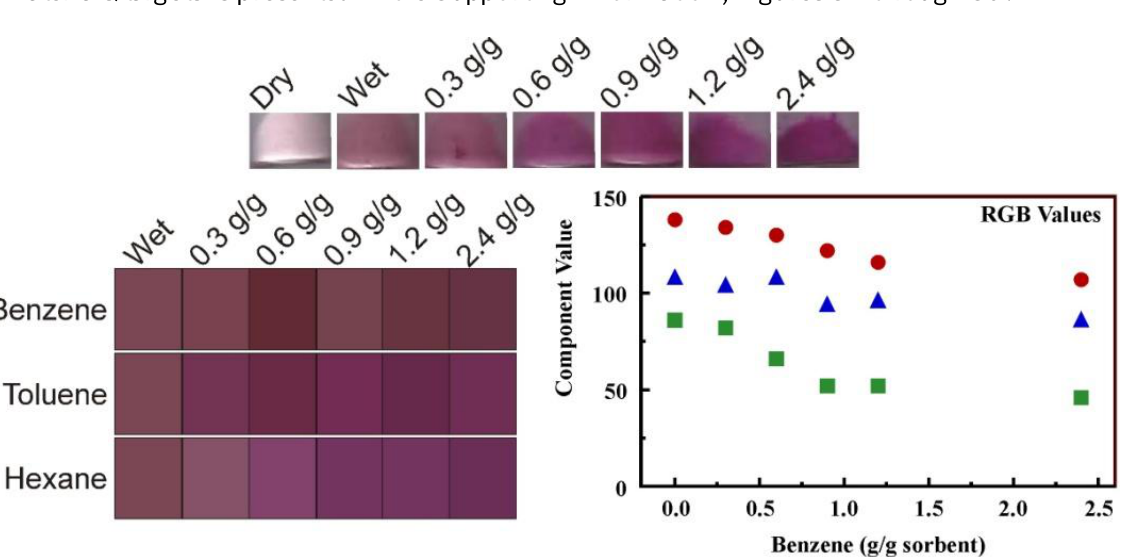
Figure 7. Interaction of FeC TPP-embedded B100 with targets. Shown here are scanner 1 images of the material following exposure to varying concentrations of benzene. Also shown are simulated images generated based on average RGB values for FeC TPP-embedded 1 B100 following exposure to varying target concentrations and the dependence of RGB image color values on target concentration for the interaction of benzene with FeC1TPP-embedded B100 (red circles = R, blue triangles = B, green squares = G). Complete data for other materials/targets is presented in the Supporting Information, Figures S4 through S9.